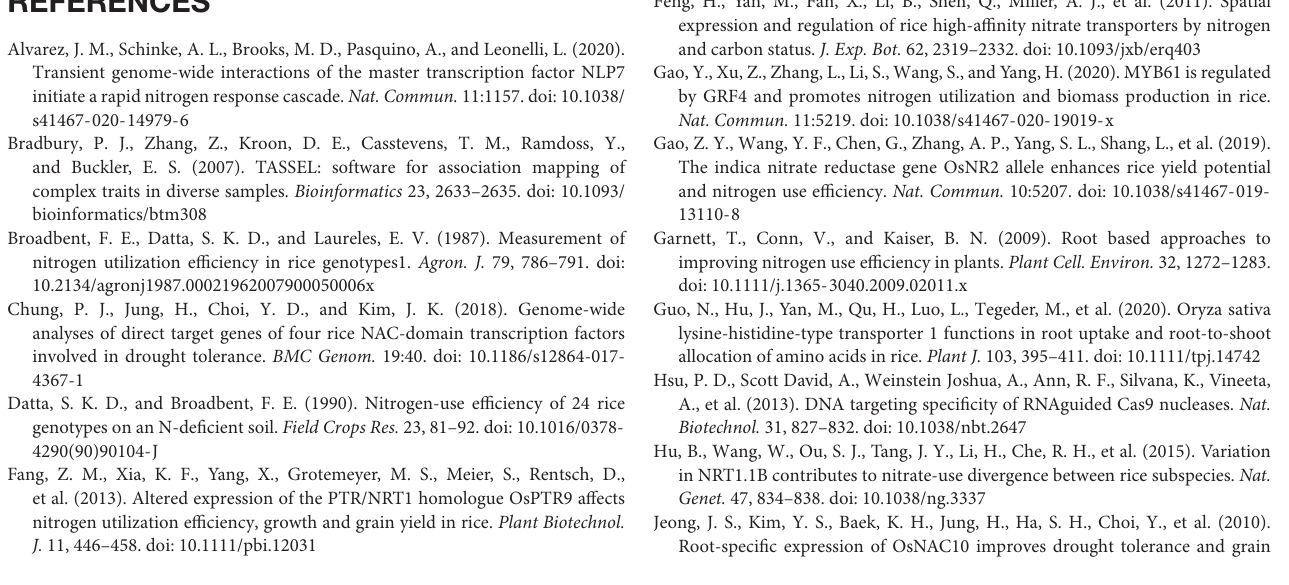
Supplementary Figure 2 | Knockout of OsNAC68 using CRISPR/Cas9 system. Sequence of wild-type transgenic line (WT) and the two mutational lines of OsNAC68 in the target region. Red letters indicated 1-bp insertions (131-13) and 4-bp deletion (131-36), Blue letters indicate the PAM region. Supplementary Figure 3 | The overexpression of NAC68 . (A) Overexpression construct for rice transformation. (B) The expression levels of 133-7, 133-11, and wild-type (WT). Supplementary Table 1 | Geographical distribution of 267 japonica rice varieties. Supplementary Table 2 | Differentially expressed genes (DEGs) in leaves and roots under deficient nitrogen conditions compared with sufficient nitrogen conditions. Supplementary Table 3 | Primers for qRT-PCR in this study.